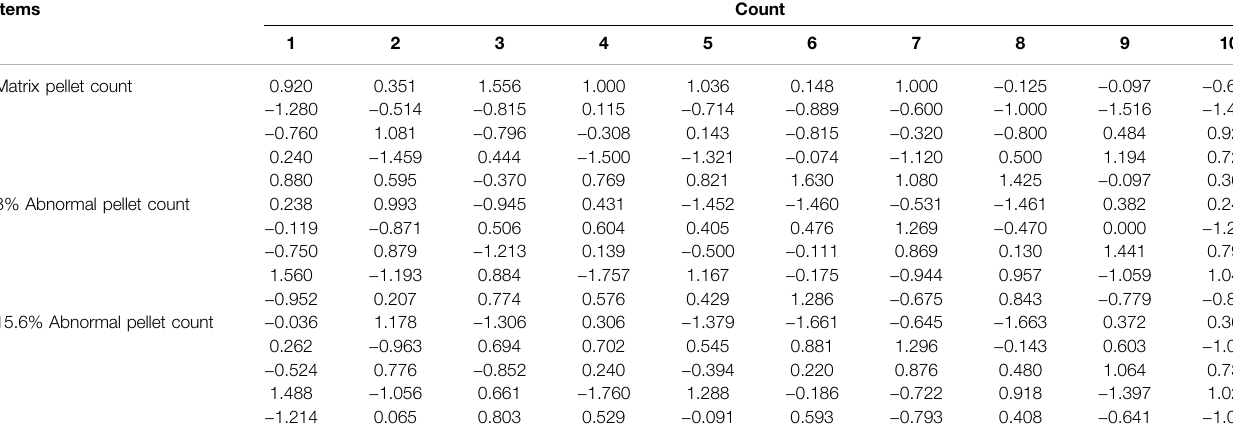
TABLE 7 | Repeatable validation data of 50 times. Items